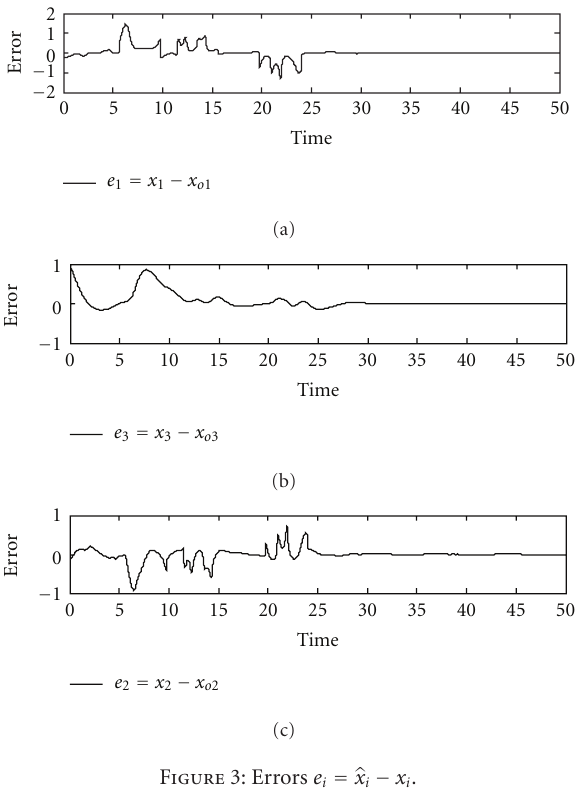
Figure 3: Errors e i = (cid:7) x i − x i